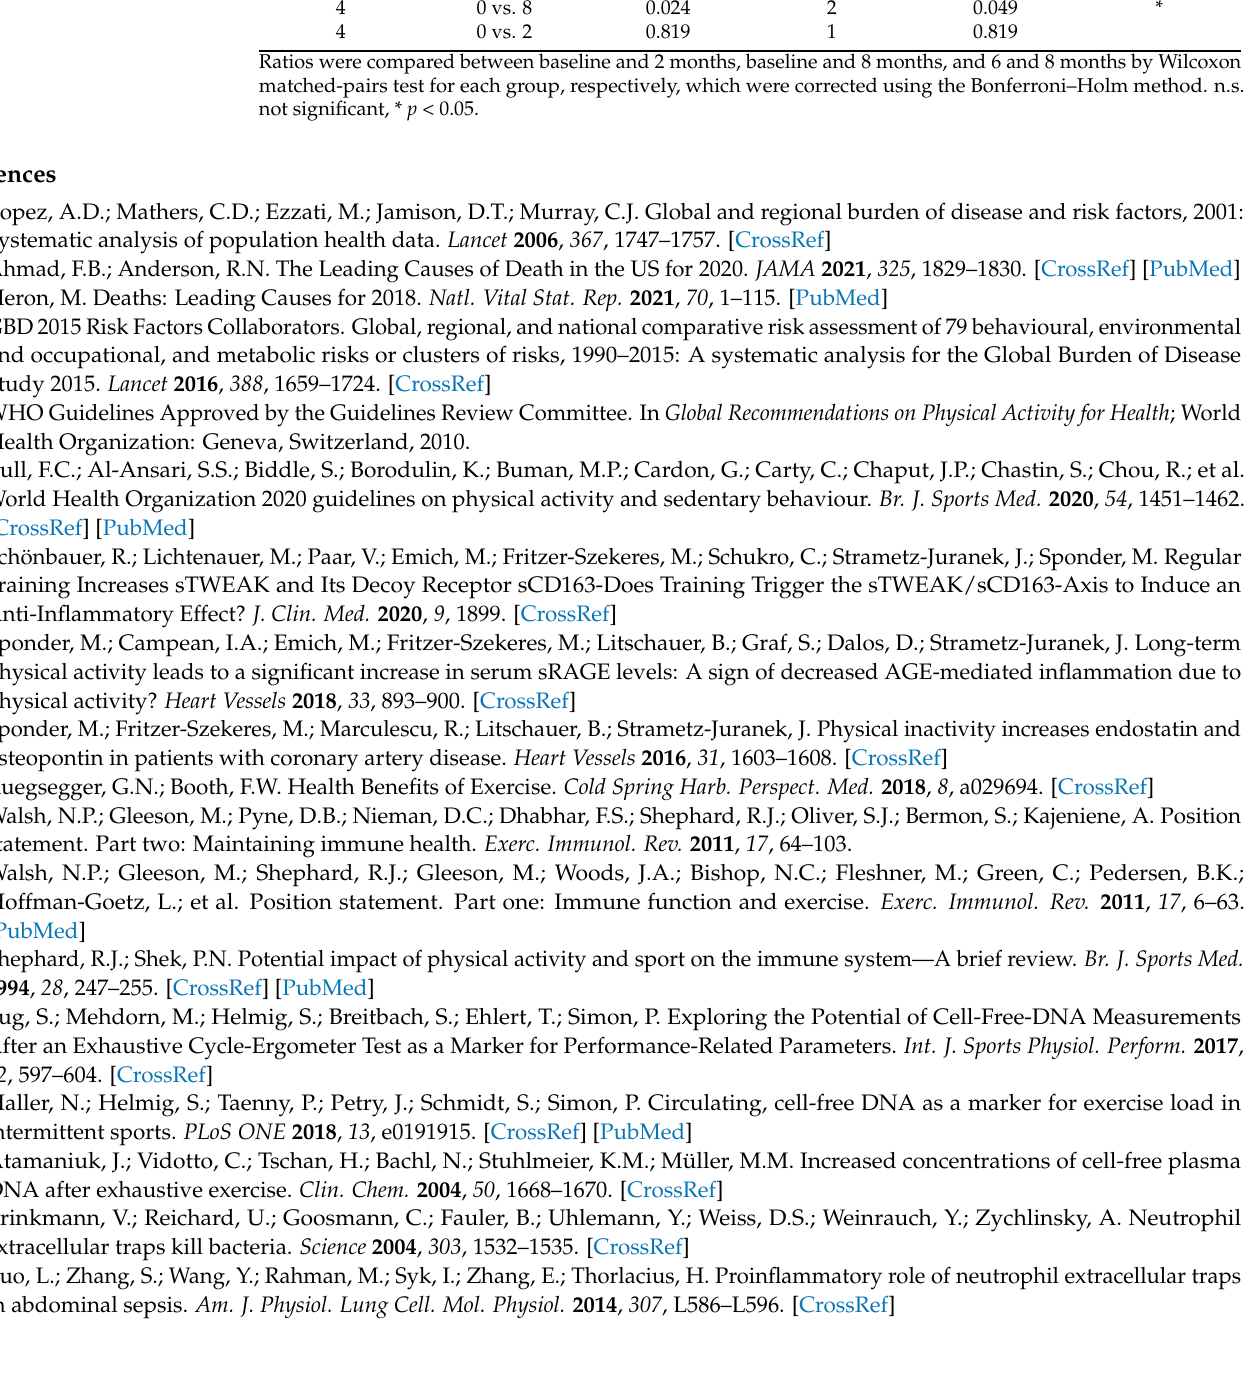
Ratios were compared between baseline and 2 months, baseline and 8 months, and 6 and 8 months by Wilcoxon matched-pairs test for each group, respectively, which were corrected using the Bonferroni–Holm method. n.s. not significant, * p <